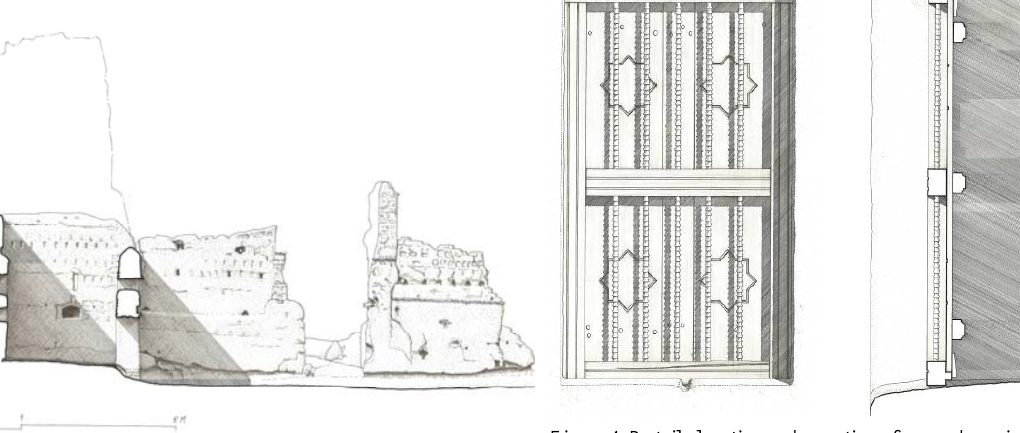
Figure 4. Detail elevation and a section of a wooden window of Mosque in Al Qattara Oasis (original 1:5) produced by the